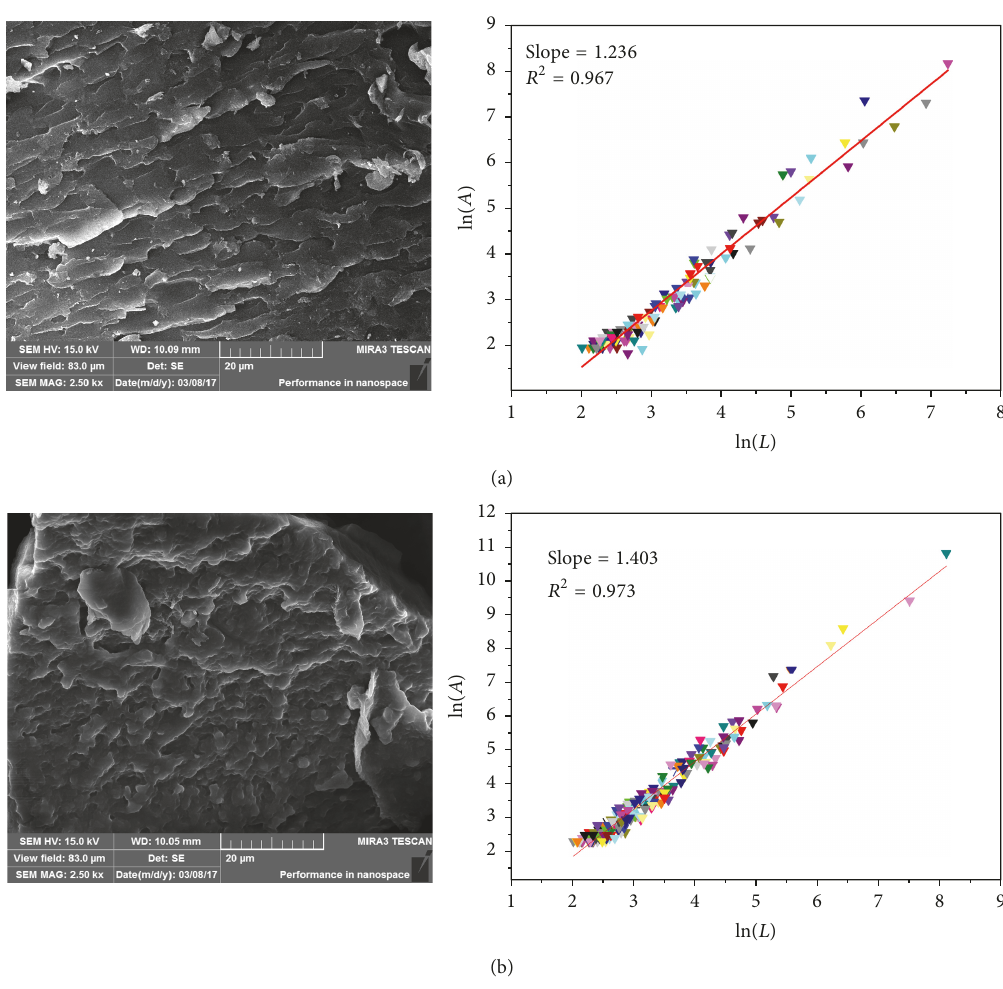
Figure 5: SEM images of (a) PAD and (b) PADA.